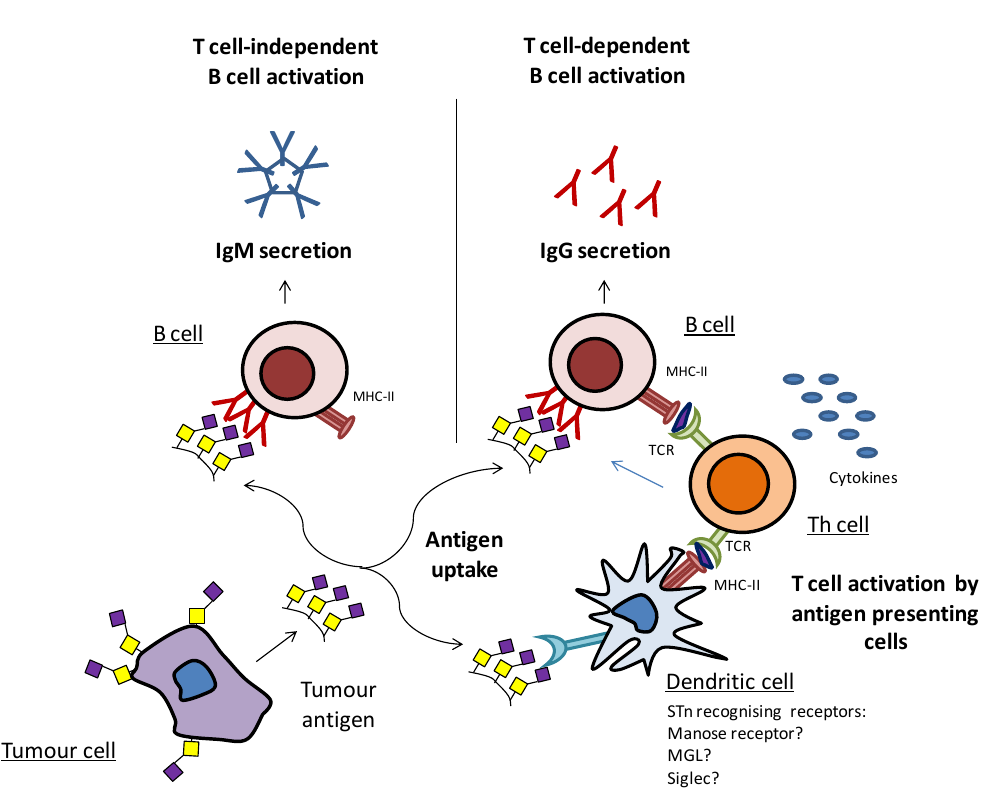
Figure 5. Simplified depiction of tumor antigen recognition and the induction of humoral immune responses. Tumor antigens can be directly recognized by B cells, and the cross-linking of the B cell receptors leads to IgM secretion through T cell-independent B cell activation. Tumor antigens can be endocytosed by antigen presenting cells, such as DCs and then presented to Th cells, thus leading to T cell activation and subsequent T cell-dependent B cell